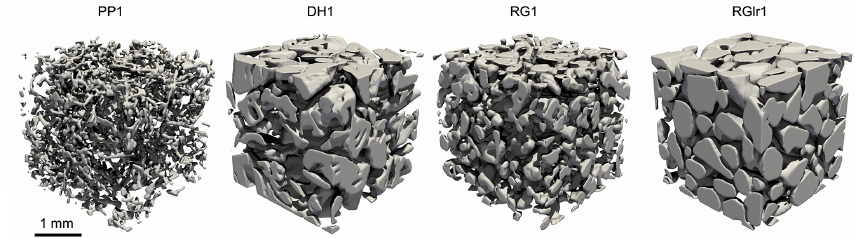
Figure 4. Three-dimensional view of the microstructure of some representative samples: precipitation particles (PP1), depth hoar (DH1), rounded grains (RG1) and large rounded grains (RGlr1). The ice matrix is shown in gray; the pore space is transparent. Sub-samples shown are cubic with a side length of 3mm. Details on the data acquisition can be found in Peinke et al. (2020). Table 1. Overview of the detailed properties of the snow samples used. Snow types are classified according to the international classification of snow on the ground (Fierz et al., 2009). The density and specific surface area (SSA) are derived from the tomographic images from Peinke et al. (2020). Additionally, the standard deviations σ R of the detrended profiles are